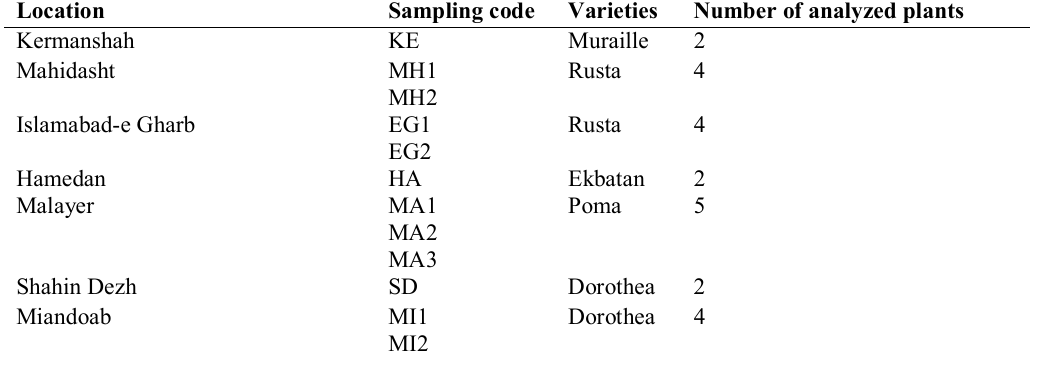
Fig.1. Map of Iran showing sampling sites. Table 1. Overview of major sugar beet growing areas in the west of Iran.